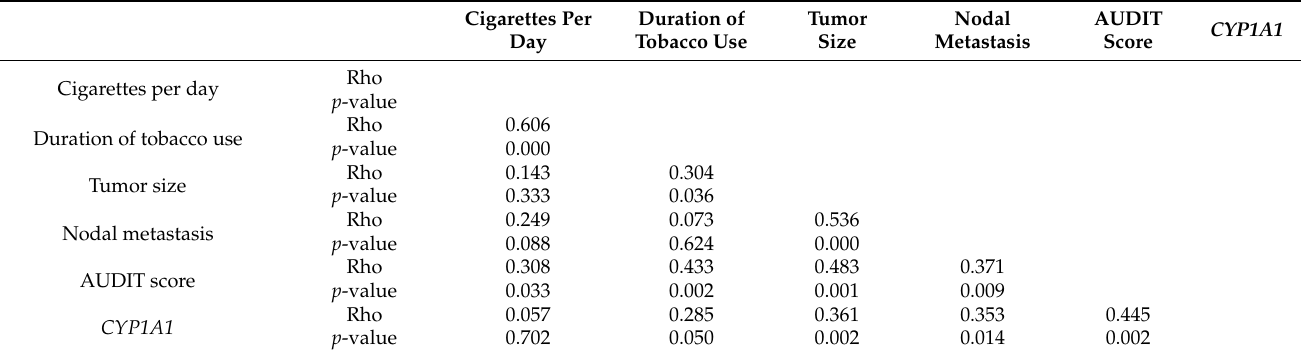
Table 3. Spearman’s correlation coefficient of whole sample.